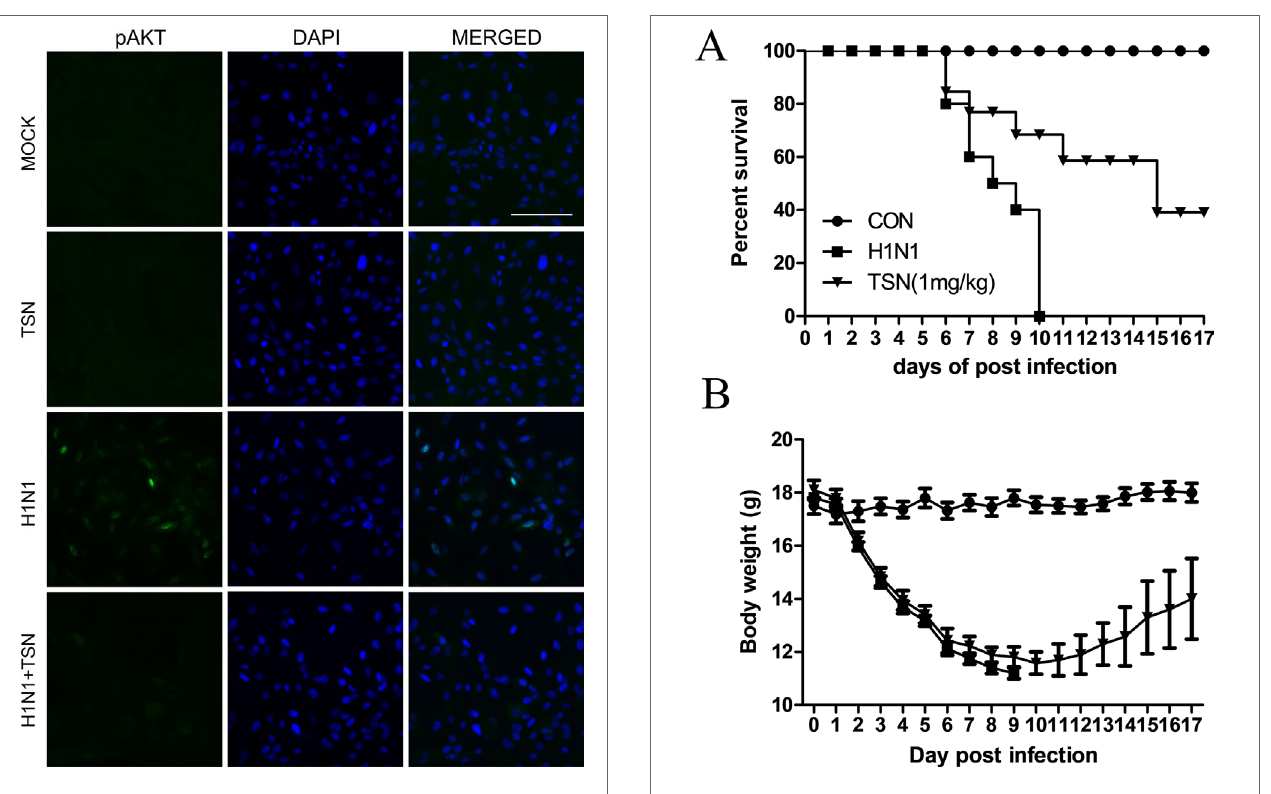
FIGURE 8 | TSN pretreatment inhibited the phosphorylation of AKT induced by influenza A virus infection. MDCK cells were pretreated with TSN at 2 µM for 6 h prior to infection by 10 MOI A/PR/8/34. Cells were stained with anti- phospho-AKT antibody (left column, green) and counterstained with DAPI (middle column, blue) at 18 hpi. The phospho-AKT protein and DAPI image are merged (right column). Data are representative of three independent experiments. Scale bars, 100 µm at ×20 magnification.